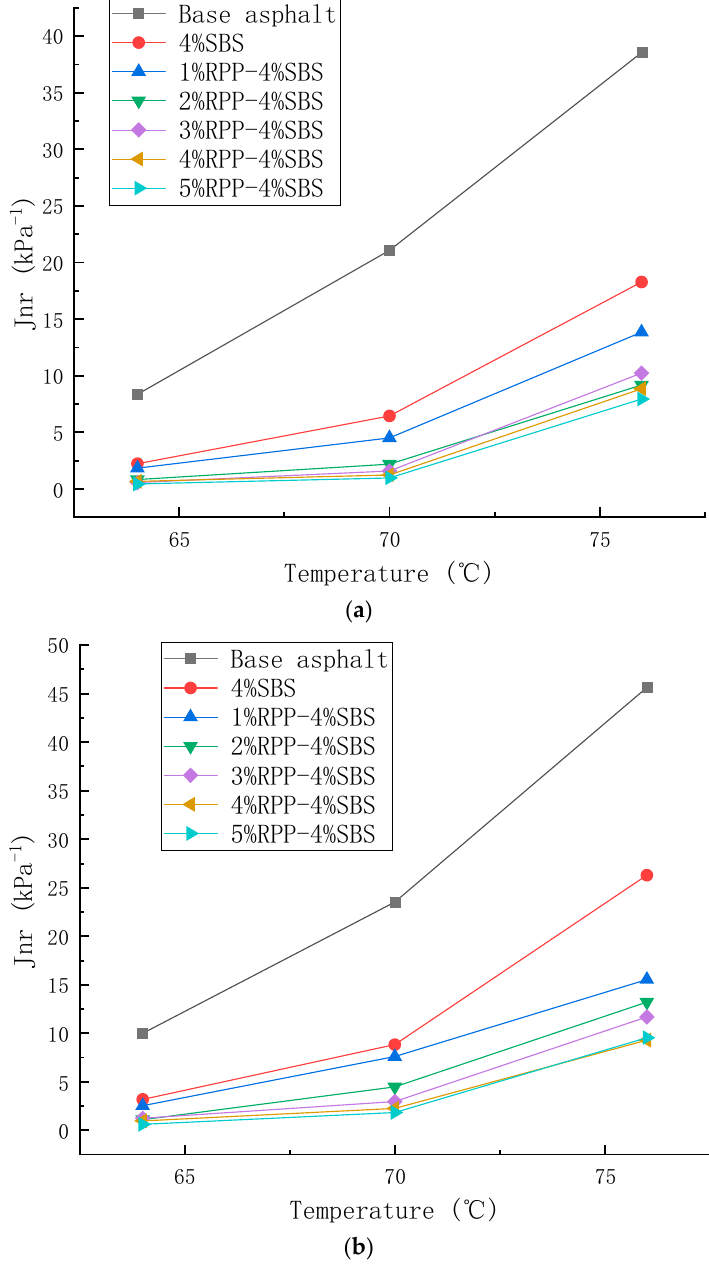
Figure 13. Changes in the unrecoverable creep compliance of asphalt with temperature under different stress levels. ( a ) 0.1 kPa, ( b ) 3.2 kPa.